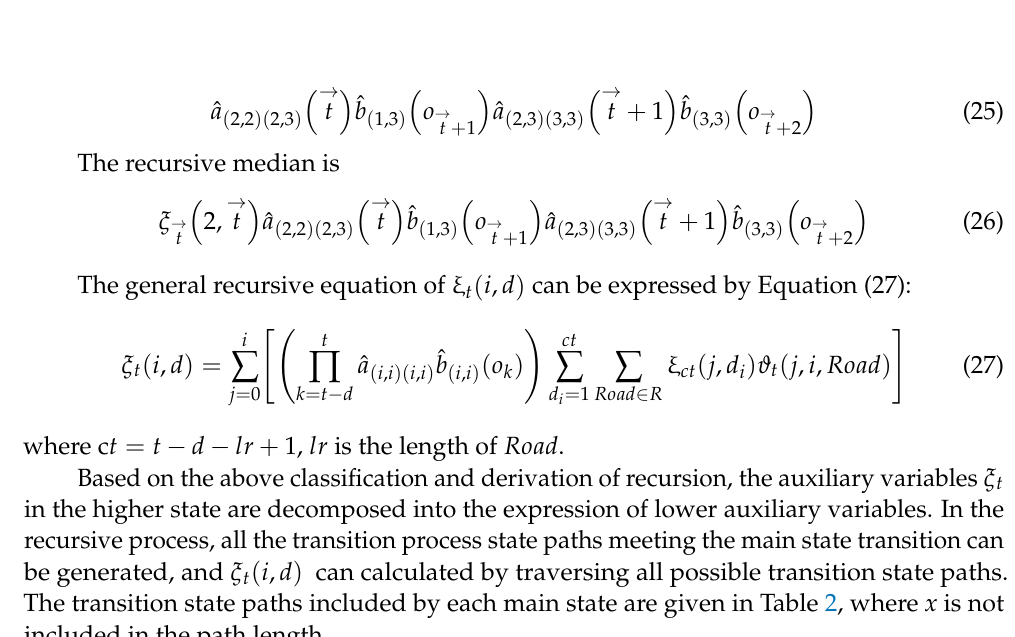
Table 2. Path generator for each main state transition process. From To Road From To Road